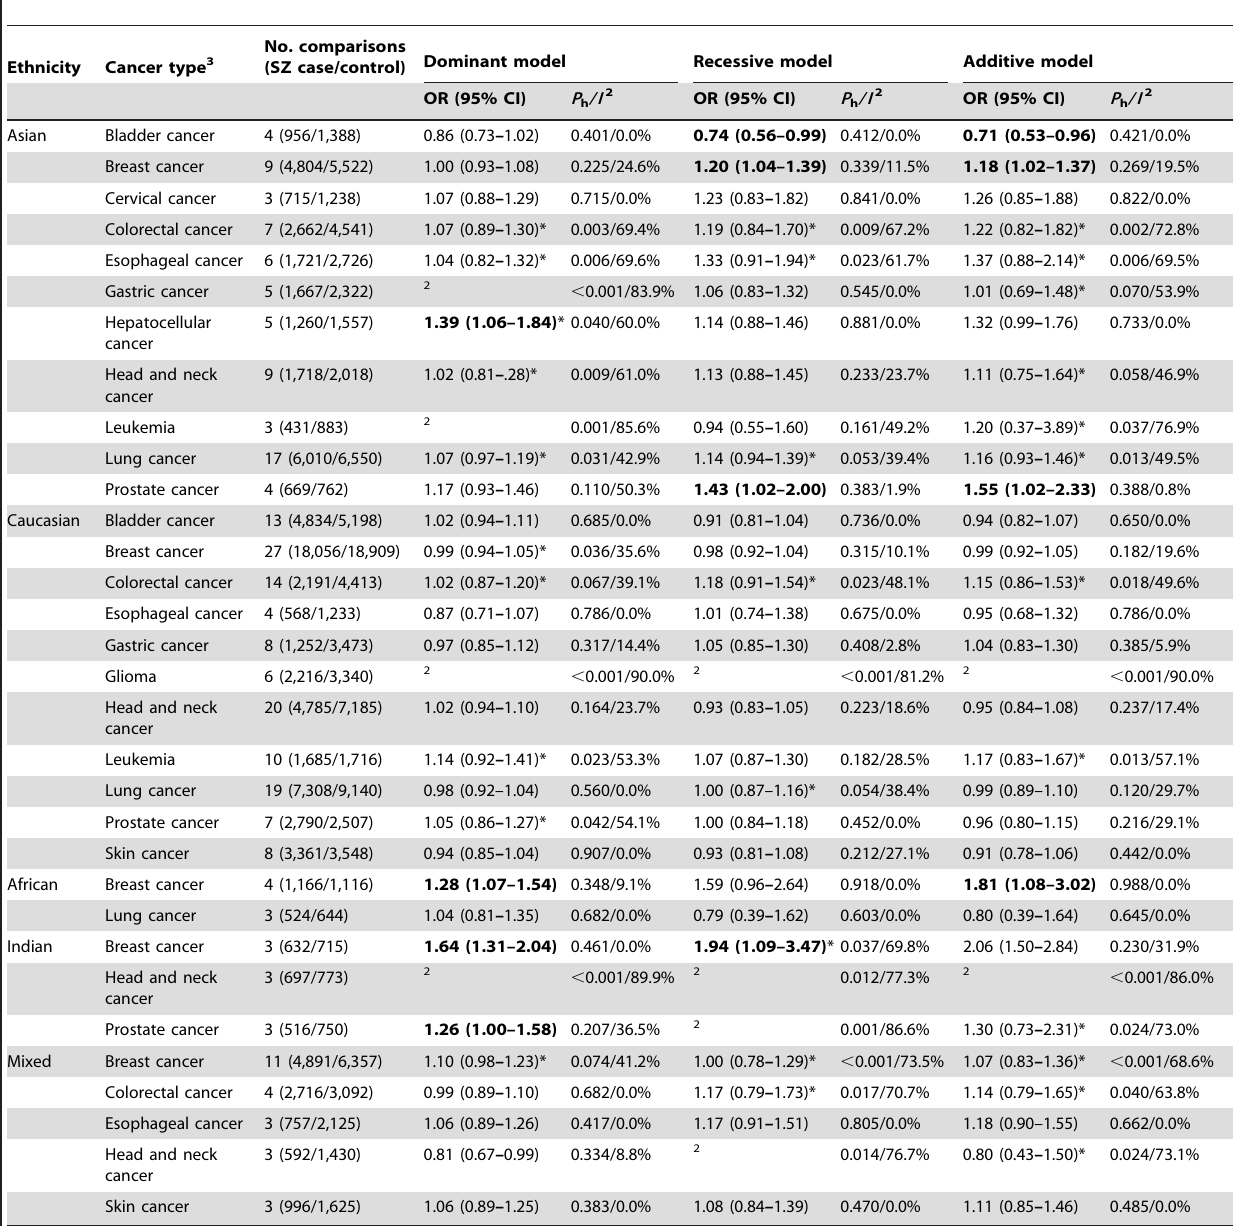
Table 2. Summary ORs (95% CI) categorized by ethnicity for the XRCC1 Arg399Gln polymorphism under different genetic models and cancer type 1